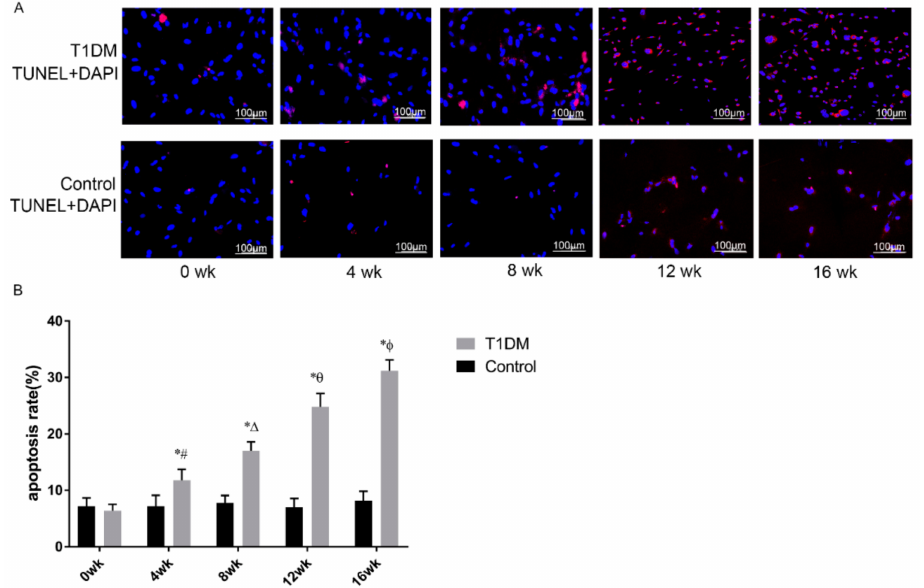
Figure 5. ASC apoptosis. ( A ): Apoptosis in Passage 3 ASCs in the T1DM group after 0, 4, 8, 12, and 16 weeks or control group at the same time points was detected with TUNEL staining. Scale 200 × . ( B ): Apoptosis rate was higher at 4, 8, 12, and 16 weeks in T1DM group compared with control group at the same time point. *, p < 0.05. Intra-group comparison in the T1DM group showed that the apoptosis rate of ASCs gradually increased with the prolongation of the course of diabetes. #, p < 0.05, vs. 0 week of T1DM. ∆ , p < 0.05, vs. 4 weeks of T1DM. θ , p < 0.05, vs. 8 weeks of T1DM. Φ , p < 0.05, vs. 12 weeks of